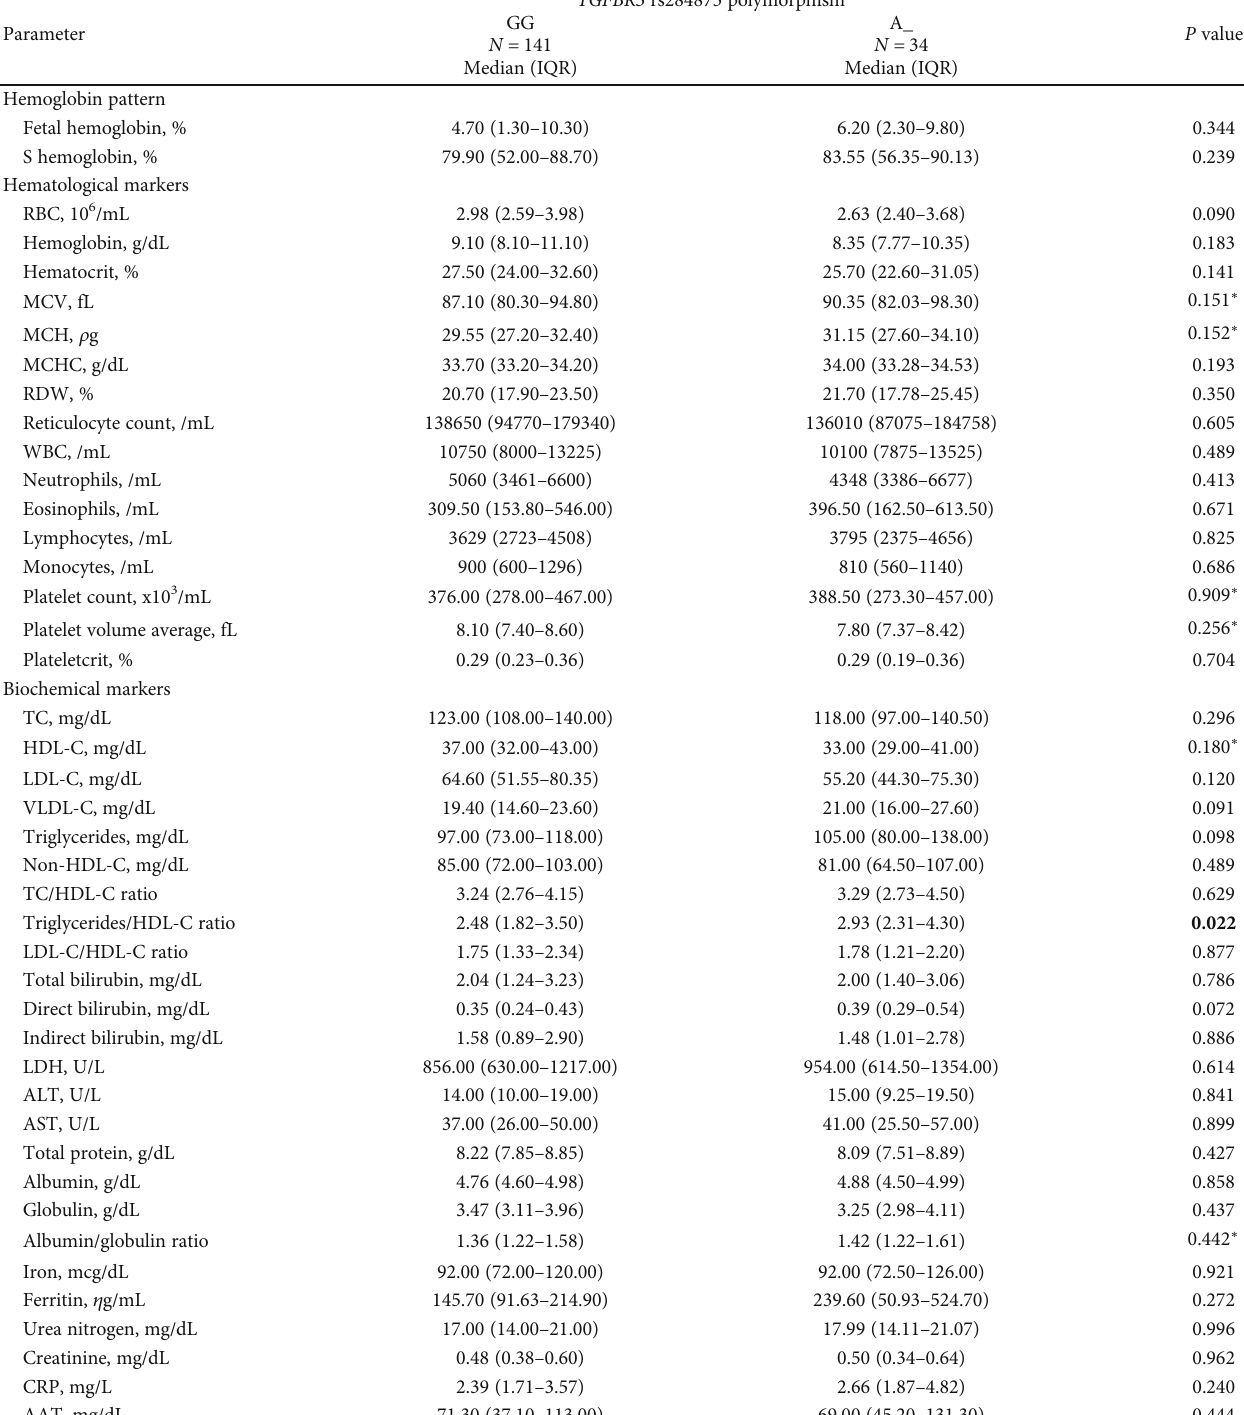
Table 3: Association of TGFBR3 rs284875 polymorphism with laboratory biomarkers using the recessive genetic